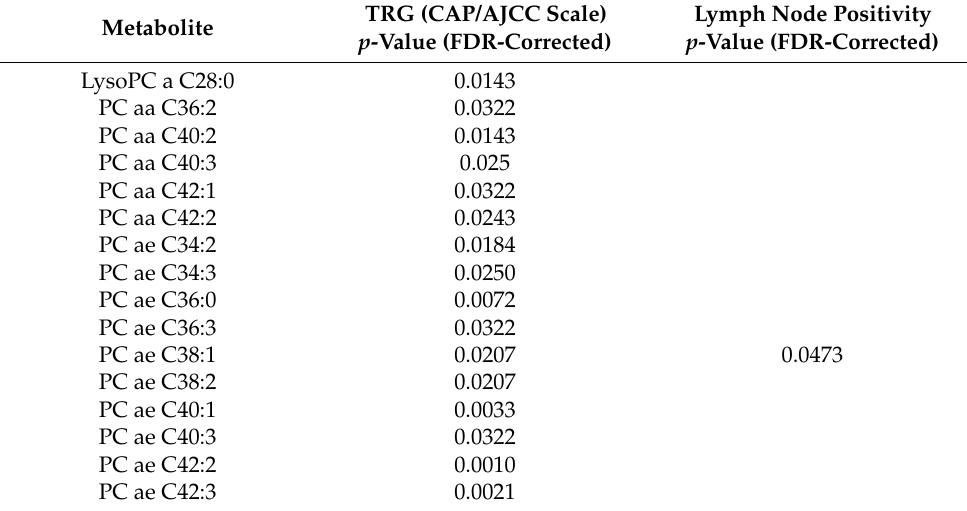
Table 3. GLM analysis of metabolite alterations in pre-treatment sera from rectal cancer patients significantly associated with clinical